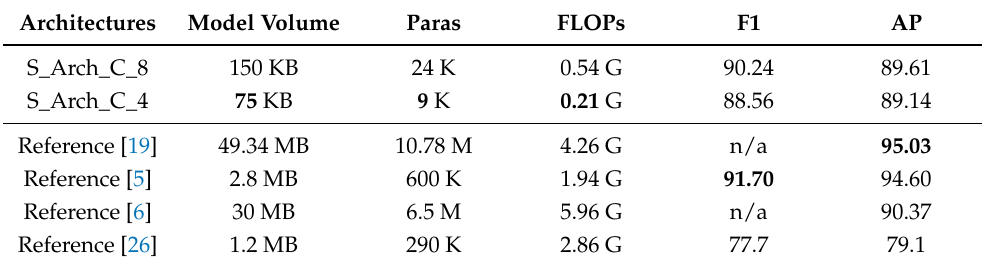
Table 11. Comparison with references on